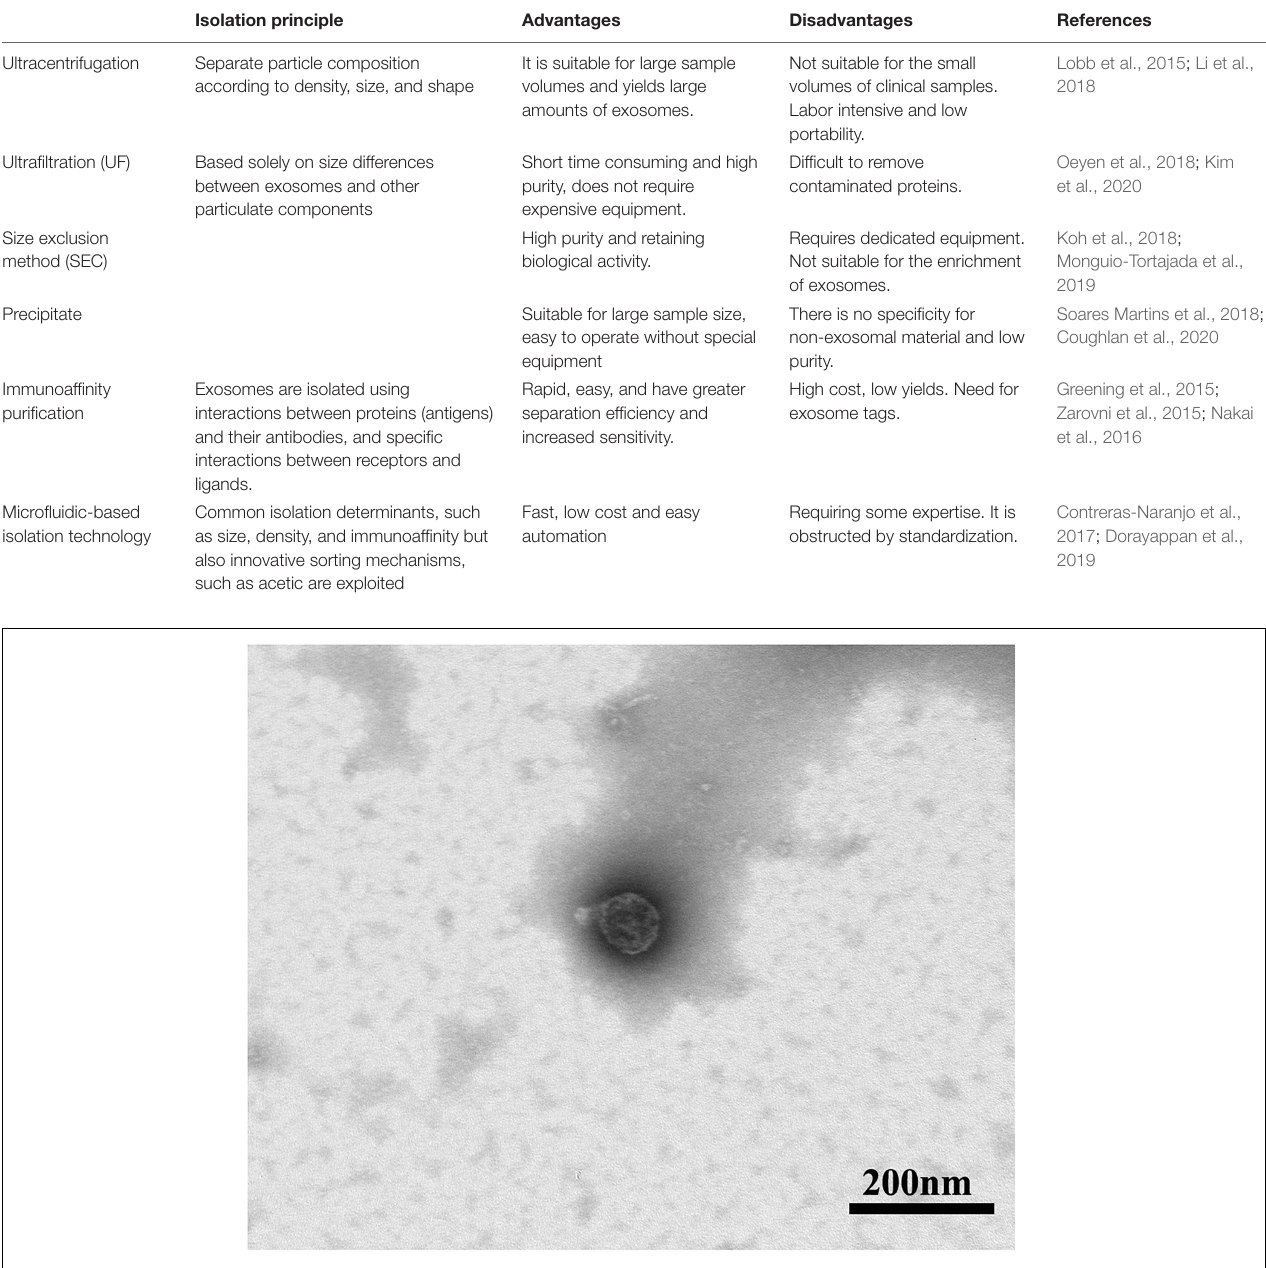
TABLE 1 | Comparison of isolation methods of exosomes.